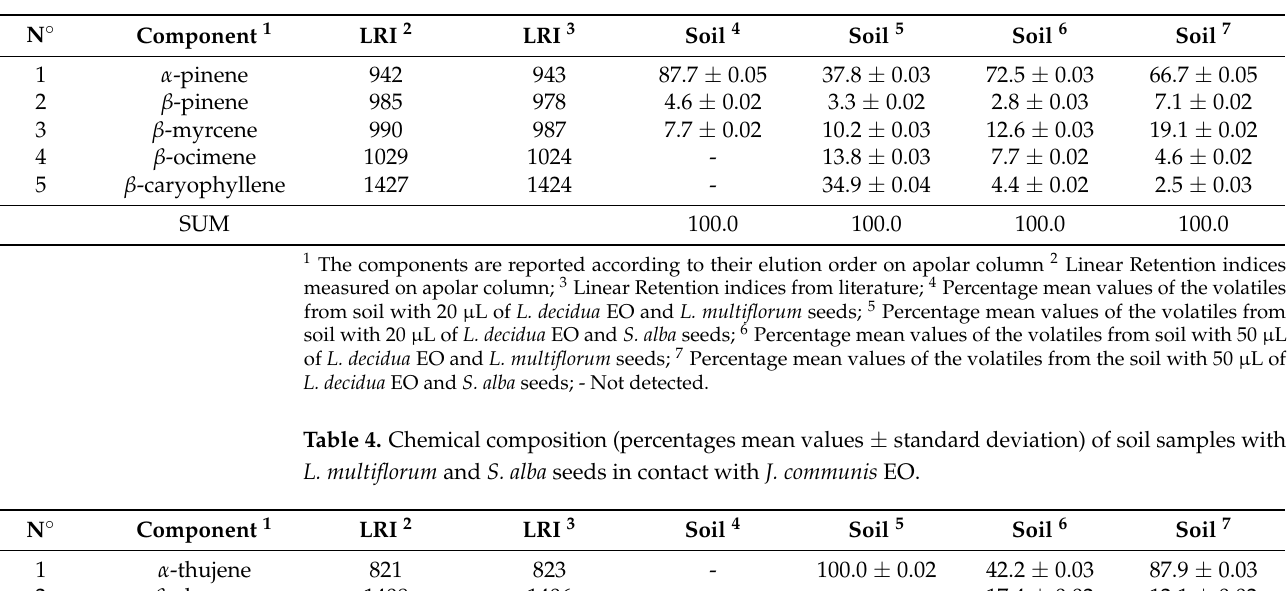
Table 3. Chemical composition (percentages mean values ± standard deviation) of soil samples with L. multiflorum and S. alba seeds in non-contact with L. decidua EO.